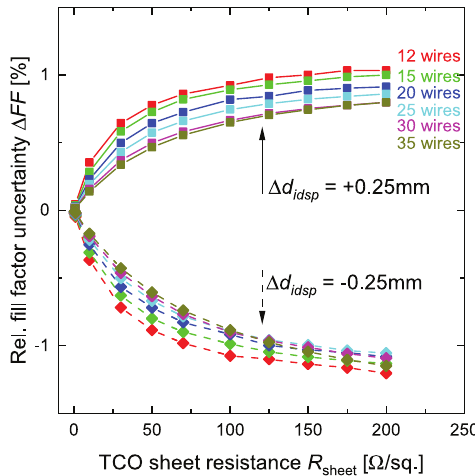
Fig. 7. Rel. uncertainty in FF (cid:1) measurement due to a misplacement of (cid:1) 0.25 (diamonds, dashed line) and +0.25 (squares, compact line) of the voltage sense contact depending on R Sheet of the TCO for different wire/bar